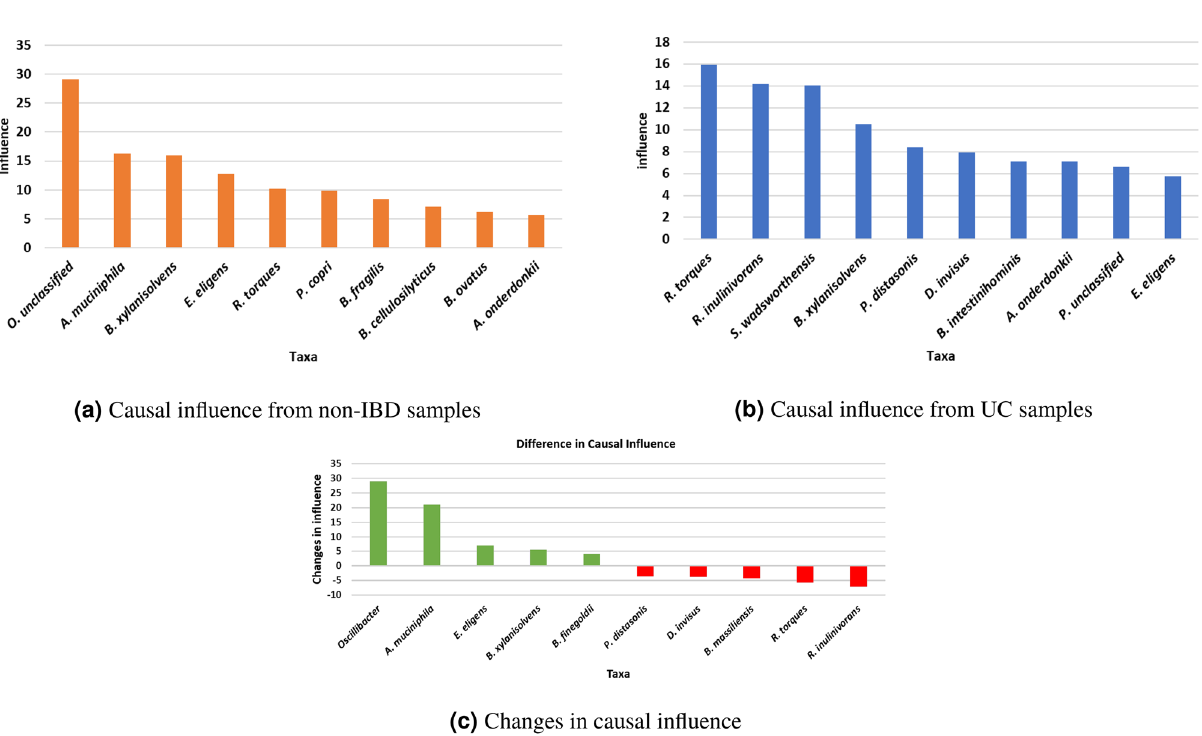
Figure 7. Top ten causally influential taxa from ( a ) non-IBD, ( b ) UC, and ( c ) the top 10 taxa with the highest change in causal influence from healthy to UC. Positive changes are shown as green bars and negative changes in